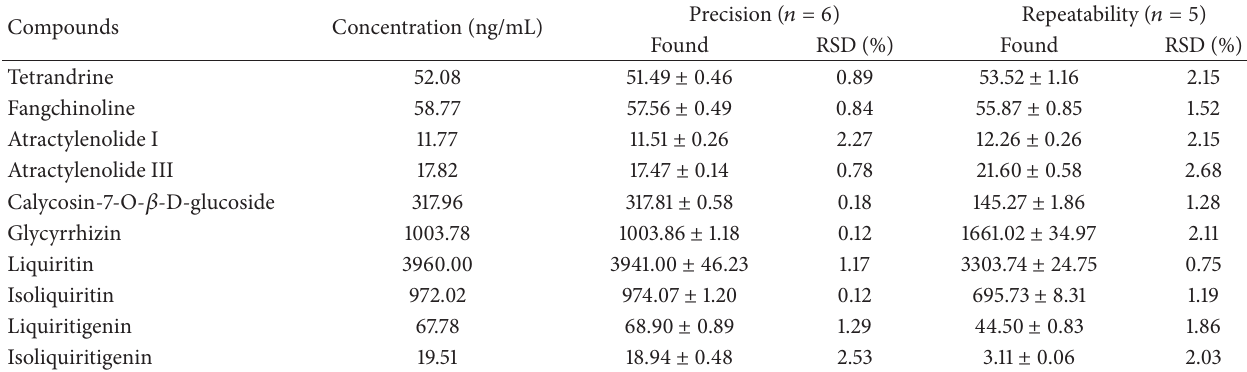
Table 3: Precision and repeatability for the assay of the 10 major